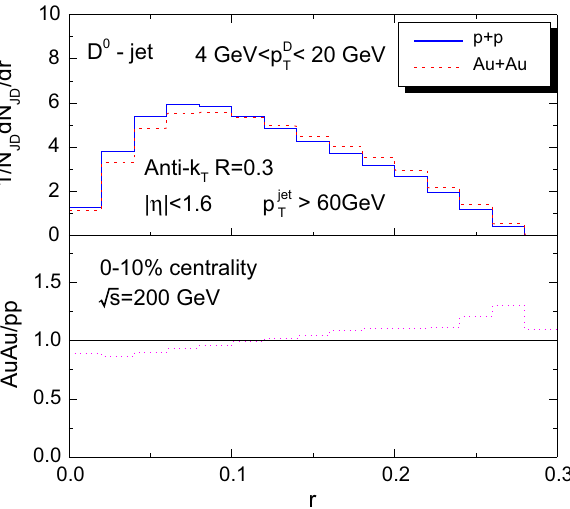
Fig. 7 The normalized radial distribution of D 0 meson in jets in p + p and 0 − 10% Au + Au collisions at ratio of Au + Au to p + p